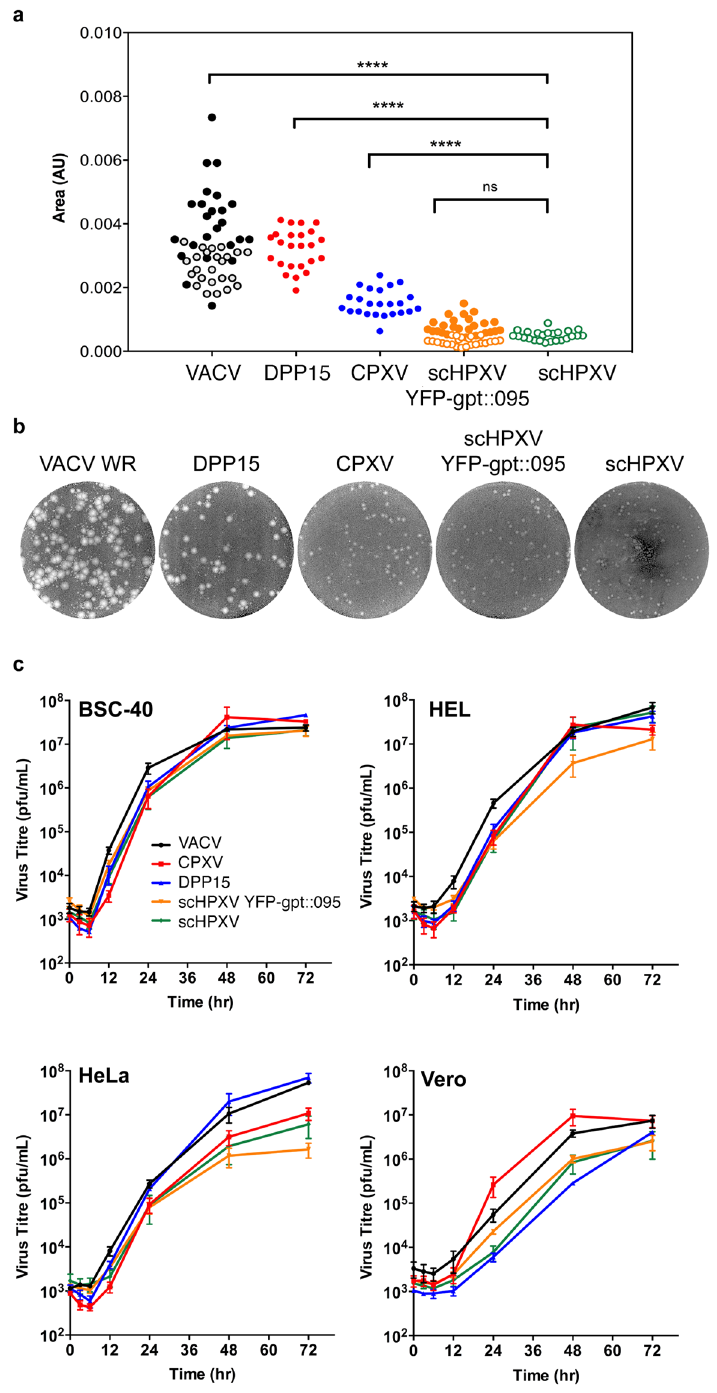
Fig 4. scHPXVYFP-gpt::095 and scHPXVgrowth properties in culture. a . Plaquesize measurements. BSC-40 cells were infected with the indicatedviruses and cultured for three days. The dishes were stained and the plaqueareas measuredusing a scanneddigital image. Approximately 8 plaqueswere measuredper virus treatment from three independentinfections(closed circles). A similar independent experiment comparing scHPXV YFP-gpt::095 and scHPXV to VACV WR was also completedas describedabove (open circles). DPP15 is a VACV clone isolated from Dryvax vaccine and CPXV is cowpox virus (strain Brighton Red). scHPXV YFP-gpt::095 and scHPXV form plaquesthat are significantly smaller than any of the other two viruses tested. Statistically significantdifferences are noted ( **** P 2 0.0001). b . Plaquemorphology seen